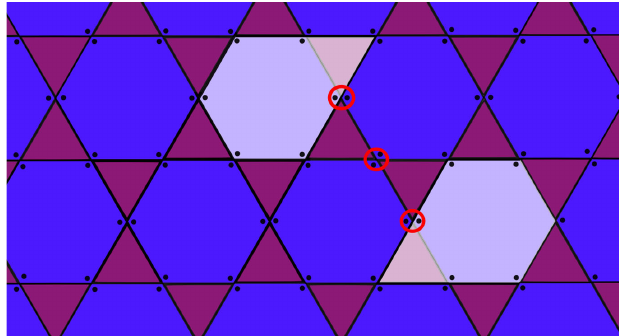
FIG. 1. Two qubits are located at each vertex of a Kagome lattice. Each pair of qubits hosts two Z 4 parafermions. To unlock their potential for non-Abelian braiding, two such parafermions need to become unpaired, which is achieved by adding a defect line to the lattice. These are strings of strong local operators acting on qubit pairs (encircled). They create unpaired parafer- mion modes located at their ends (light pentagon-shaped regions consisting of a hexagon and a